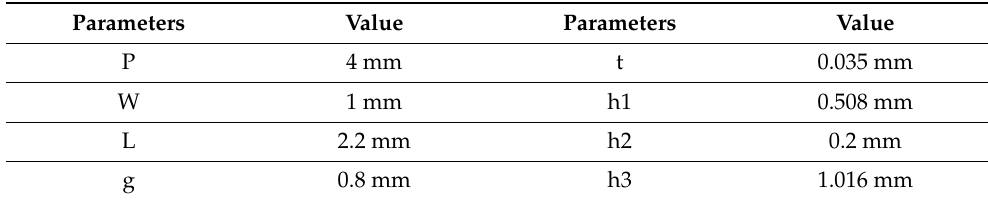
Table 1. Parameters of the proposed MSRRA unit